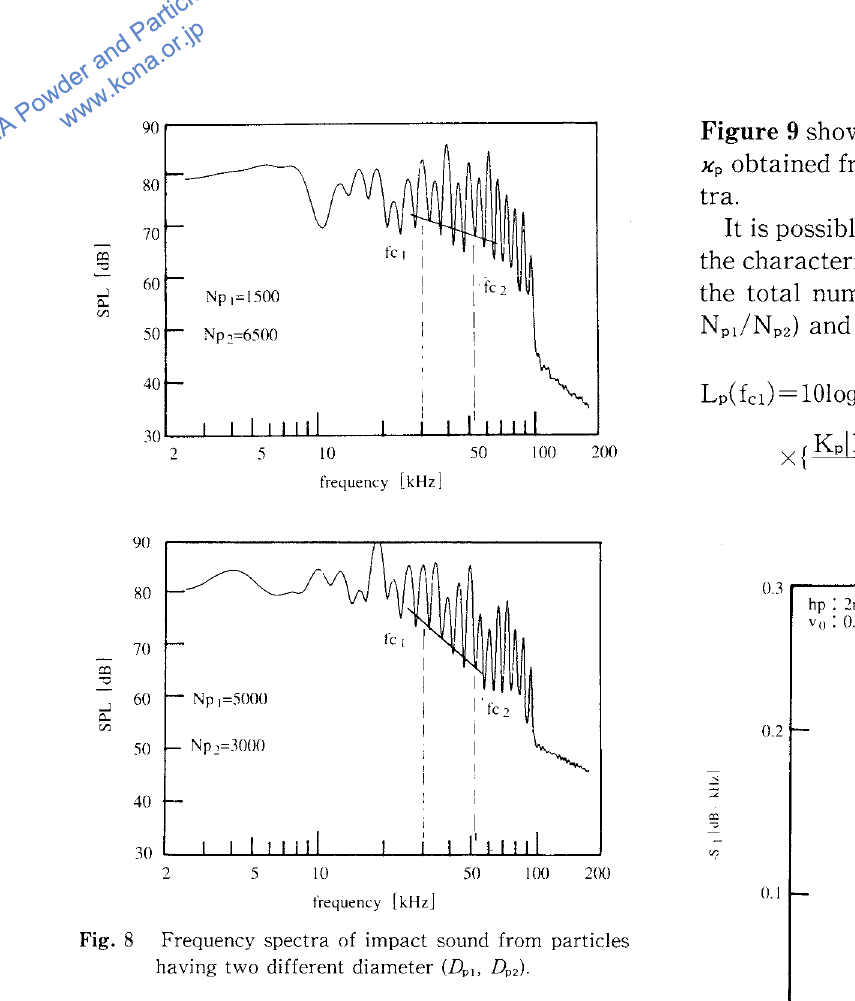
Fig. 8 Frequency spectra of impact sound from particles having two different diameter (DP" Dp 2).